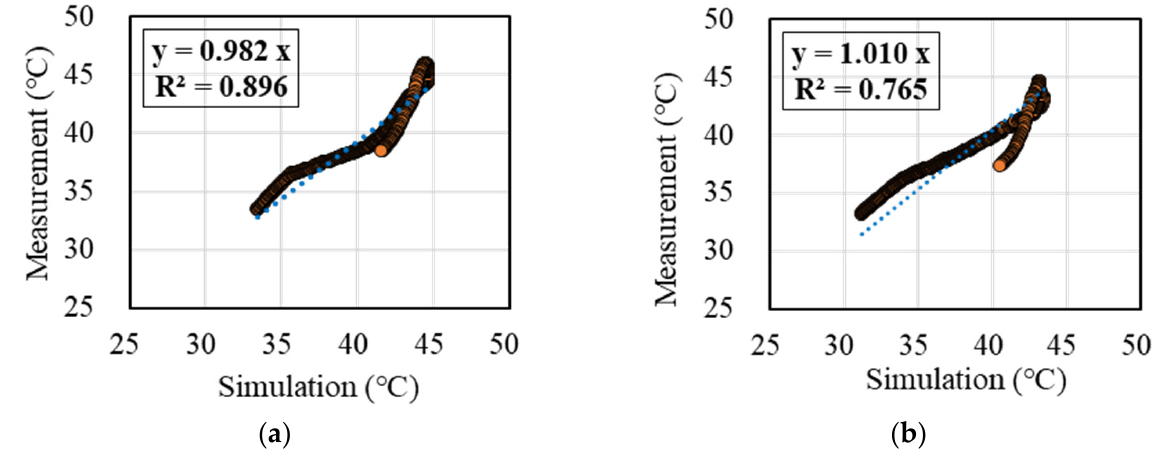
Figure 13. Scatter plot of OT. ( a ) Without Expanded Metal Mesh; ( b ) With Expanded Metal Mesh.